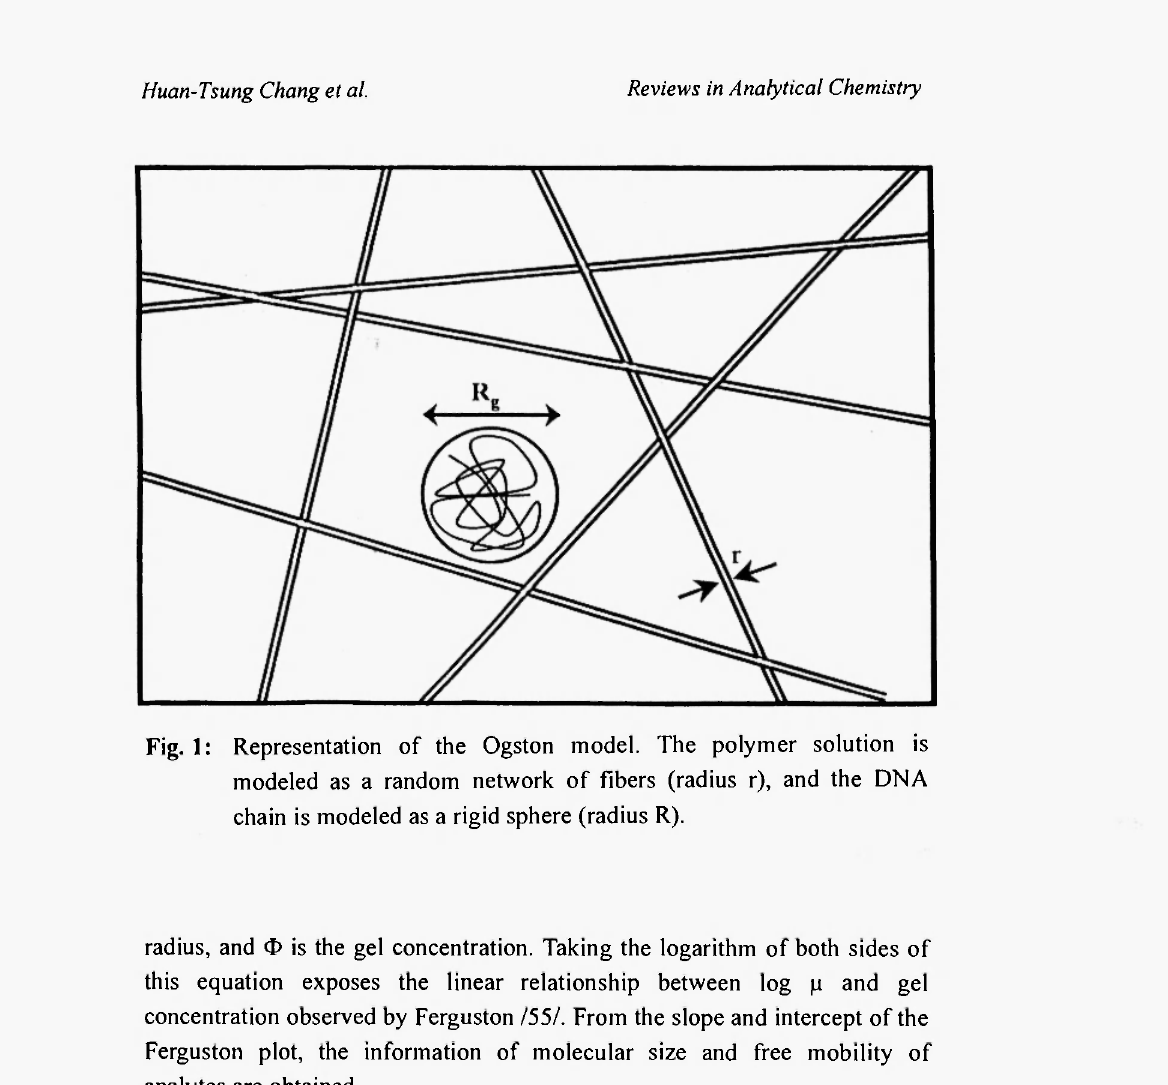
radius, and Φ is the gel concentration. Taking the logarithm of both sides of this equation exposes the linear relationship between log μ and gel concentration observed by Ferguston 1551. From the slope and intercept of the Ferguston plot, the information of molecular size and free mobility of analytes are